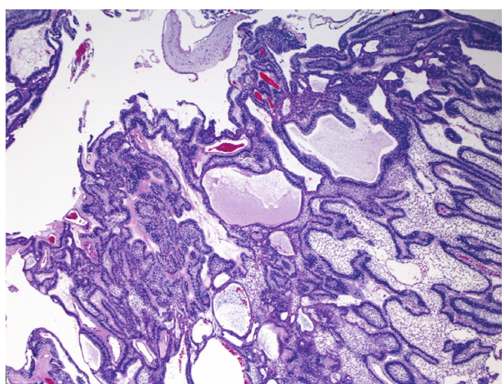
Figure 2: Cords and follicular islands of cytologically benign odontogenic epithelium permeated an edematous, myxoid, hypocellular stroma.